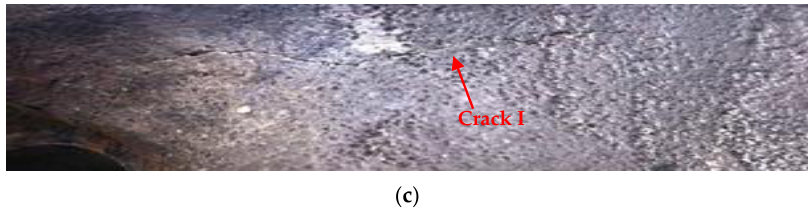
Figure 4. Tested specimen: ( a ) the PDC bit; ( b ) two cross cracks on the surface: Crack I and Crack II; ( c ) zoomed view of Crack I.